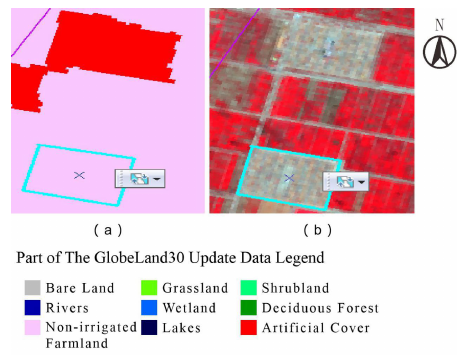
Figure 6. Artificial covers are missing updated （ a ） GlobeLand30 update data （ b ） The image used for data